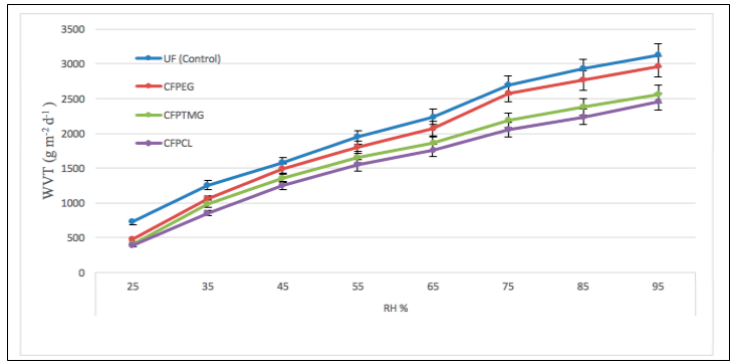
Figure 6. WVT of UF (control), CFPEG, CFPTMG, and CFPCL.